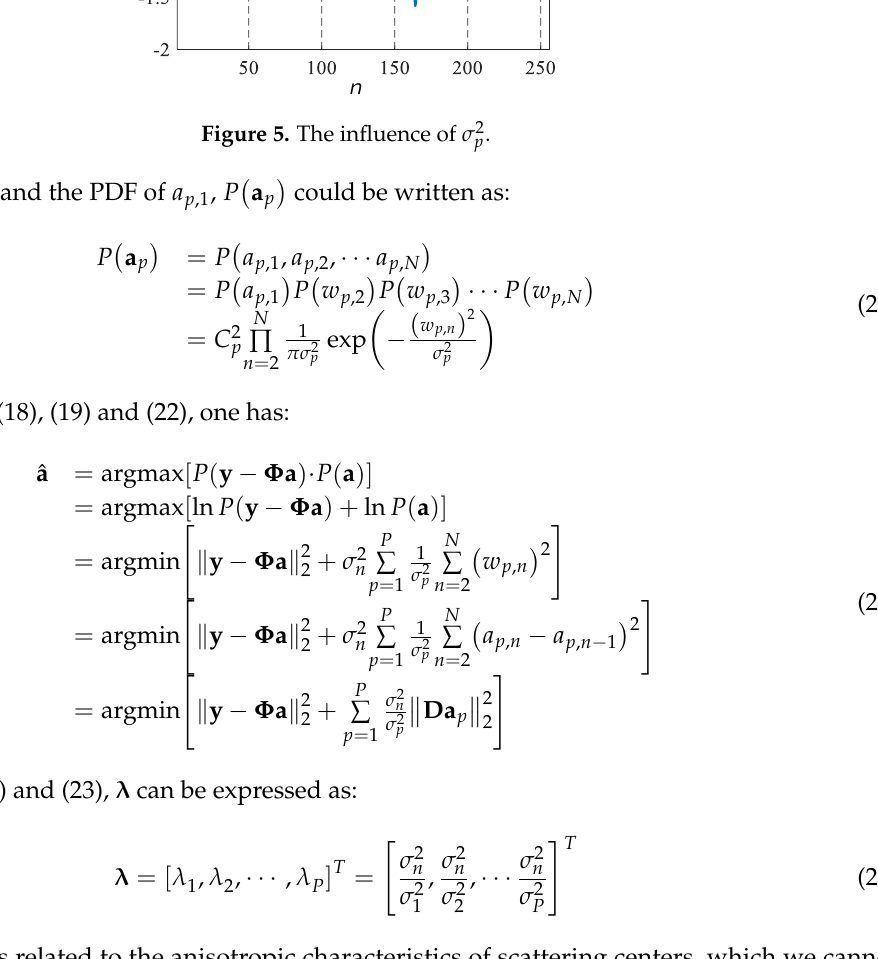
Figure 5. The influence of σ